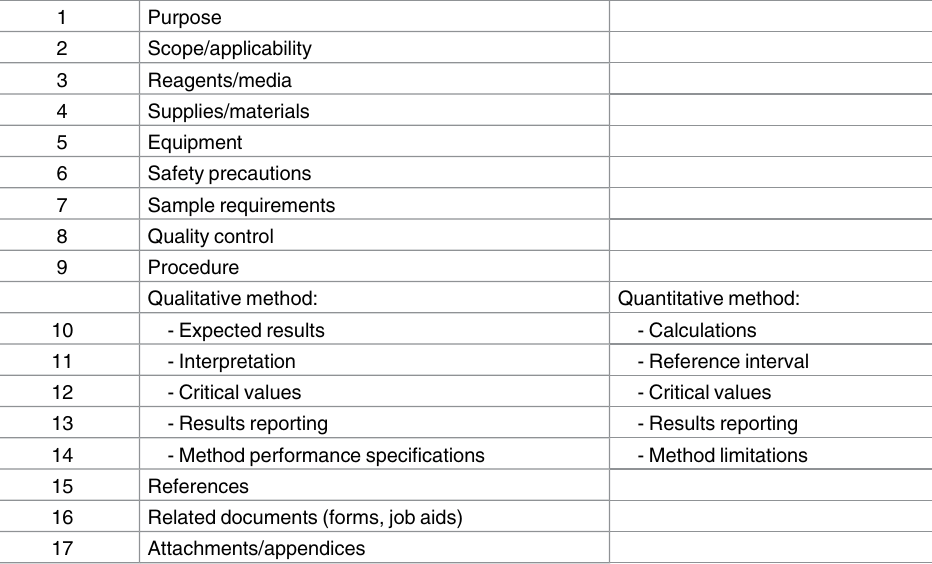
Table 2. SOP template with section headings according to CLSI guideline QMS02-A6 2013